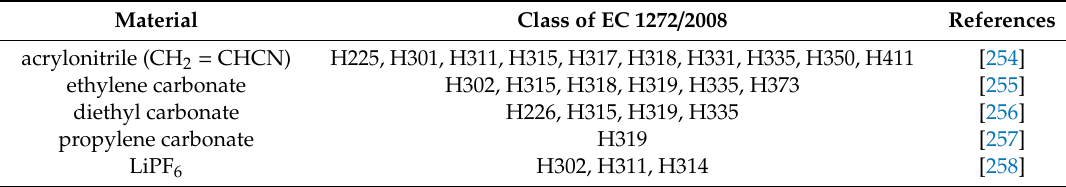
Table 9. Hazard statements of acrylonitrile (CH 2 = CHCN), ethylene carbonate, diethyl carbonate, propylene carbonate, and LiPF 6